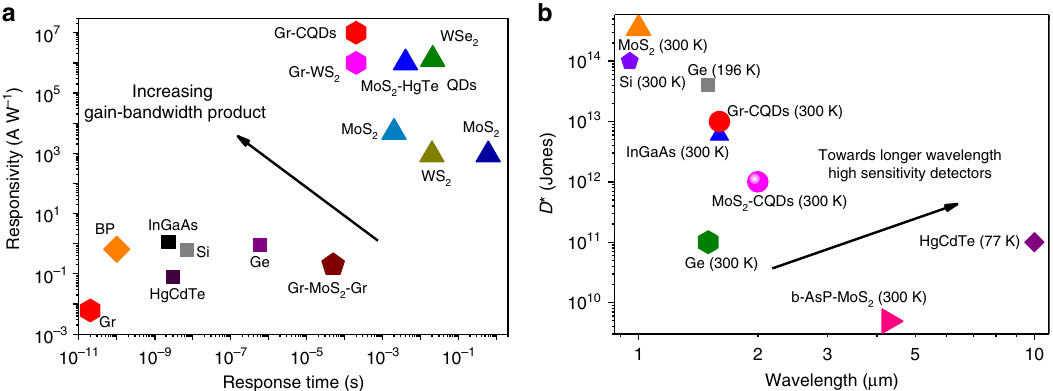
Fig. 1 Overview of performance metrics of standard and 2D-based photodetector technologies. a Various photodetector technologies plotted against their corresponding responsivity and time response. The top left region corresponds to high gain-bandwidth-product detectors and should be the ultimate performance target of future 2D-based photodetectors. b Plot of the speci fi c detectivity D* of various photodetector technologies versus their absorption onset (bandgap). 2D material-based photodetectors have the potential to address the grand challenge in photodetection towards low-cost, high